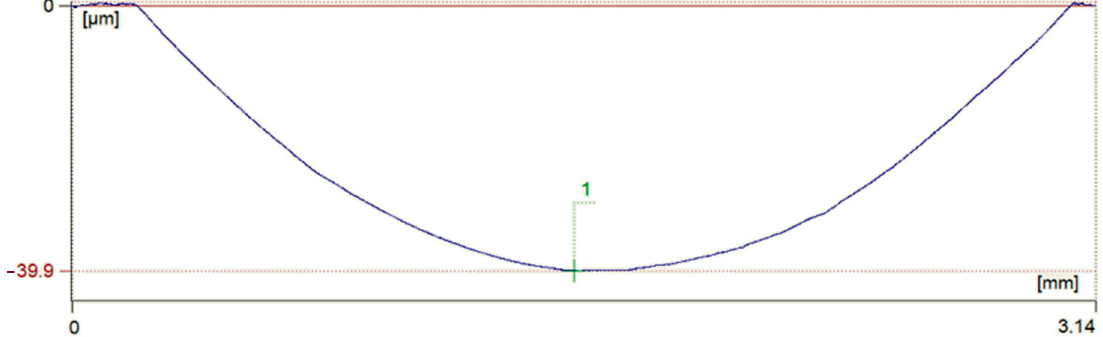
Figure 6. Measurement of depth of friction zone on specimen laser borided with v l = 50 m/min and t b = 100 µ = 100 µm. t b